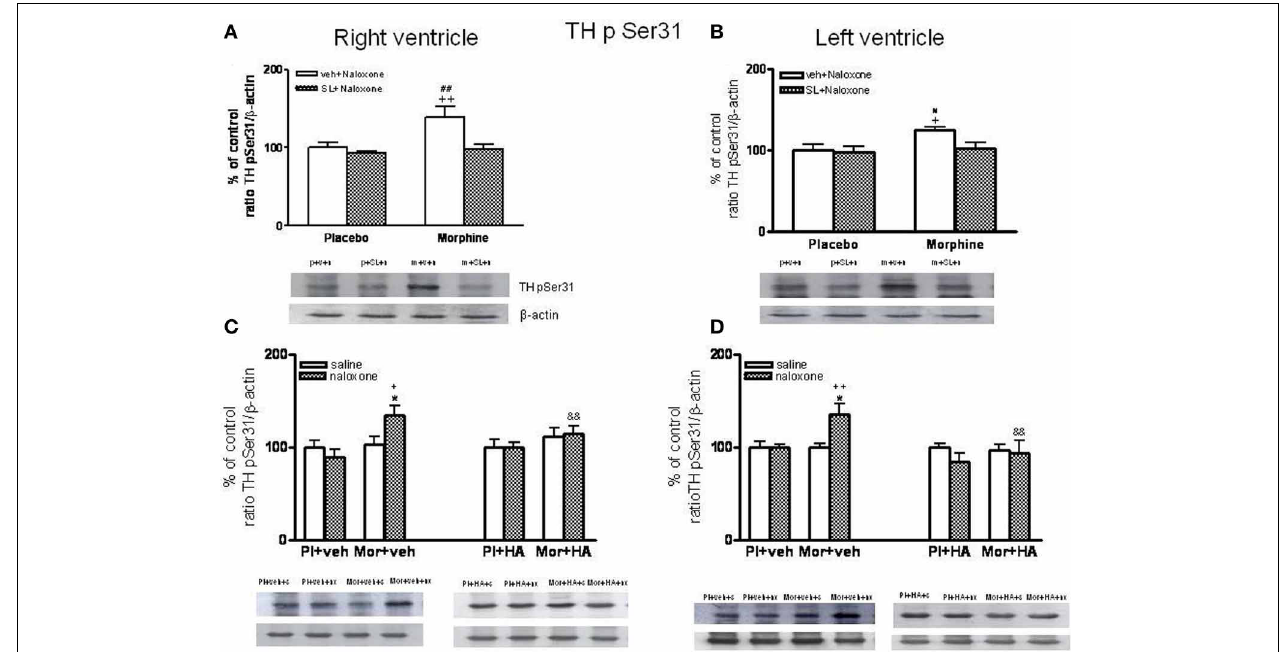
FIGURE 8 | Western blotting analysis of tyrosine hydroxylase (TH) phospho (p) Ser31 in the right ventricle and left ventricle 90min after saline (s) or naloxone (n, nx) administration to placebo (p, Pl)- or morphine (m, Mor)-treated rats receiving vehicle (v, veh) or SL327 (SL) (A,B), veh or HA-1004 (HA) (C,D). The immunoreactivity corresponding to TH phospho-Ser31 is expressed respect to the control group (p + v + n or Pl + veh + saline; defined as 100% value). Data are the mean ± s.e.m.